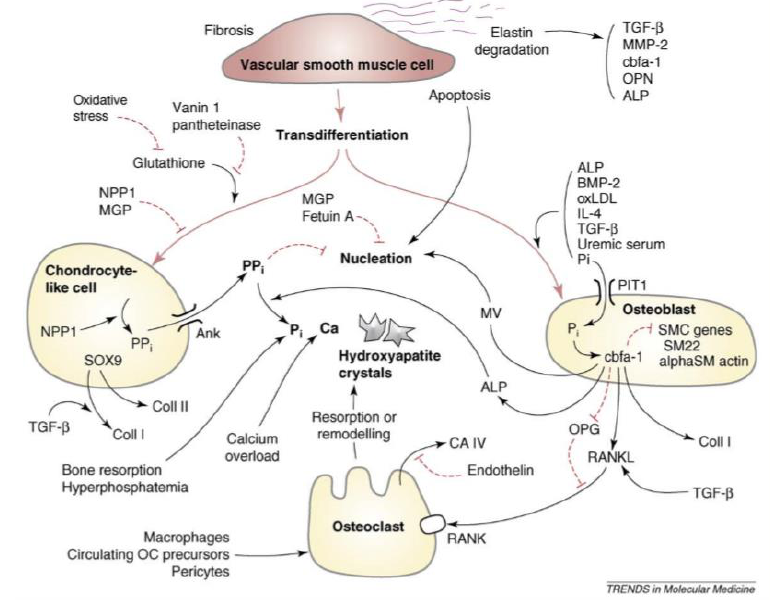
Figure 2. Pathways leading to the differentiation and mineralization of VSMCs to osteoblast-like cells. Factors and mediators shown include transforming growth factor-β (TGF-β), fetuin, hyperphosphatemia, hypercalcemia, bone morphogenetic proteins (BMPs), and nuclear factor-κB ligand (RANKL) [31].